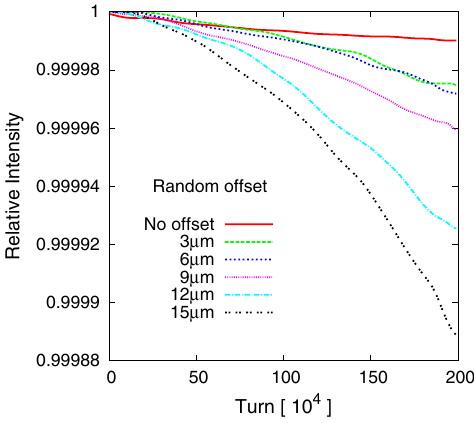
FIG. 24. Relative proton beam loss with random transverse offset between the e-lens and the proton beam in the e-lens.